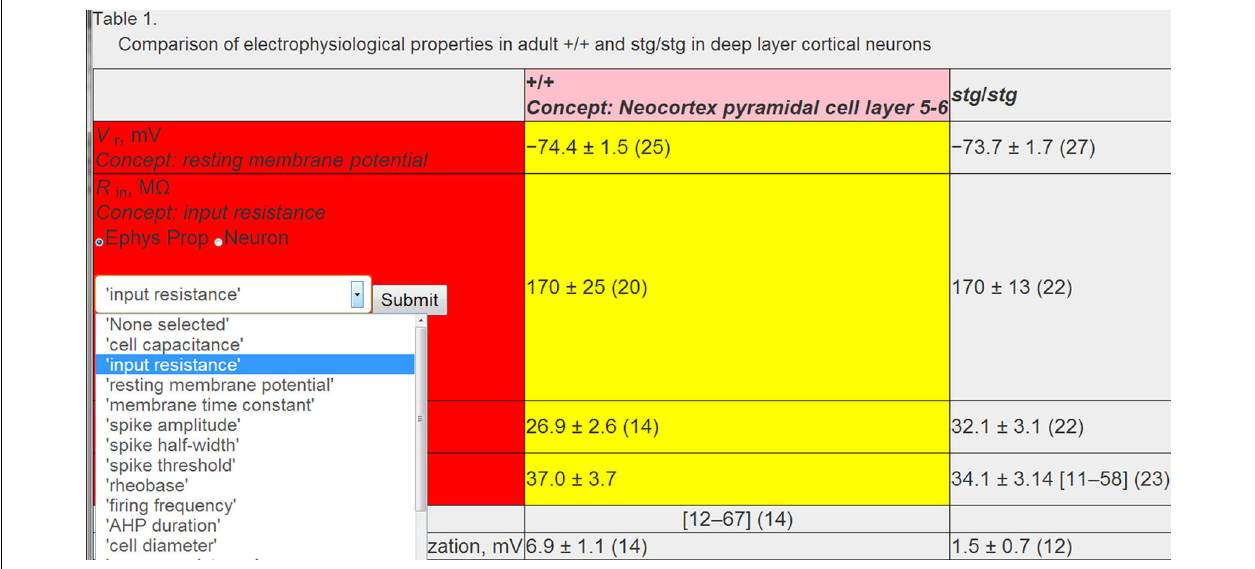
concepts using drop down menus. Example data table from Pasquale et al. (1997) and is reproduced with permission from The American Physiological